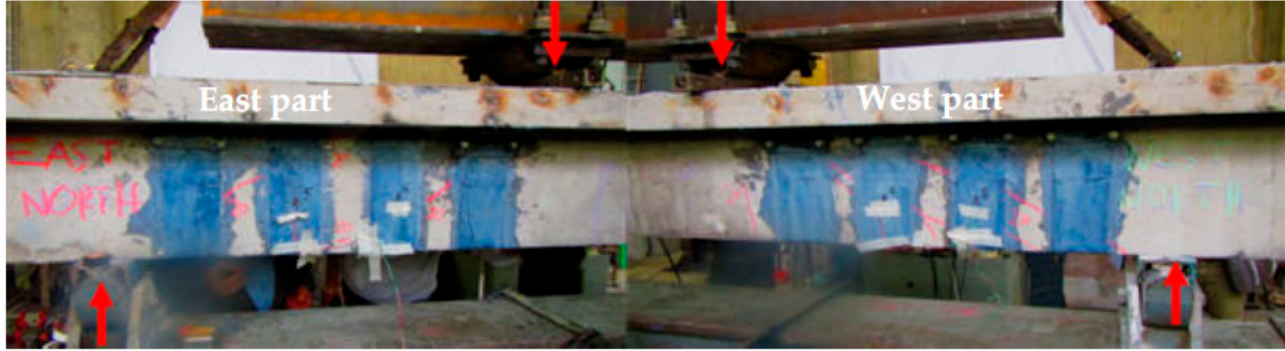
Figure 16. The East and the West parts of the prototype RC T-beam with the 1st shear st rengthening scheme under four-point bending.